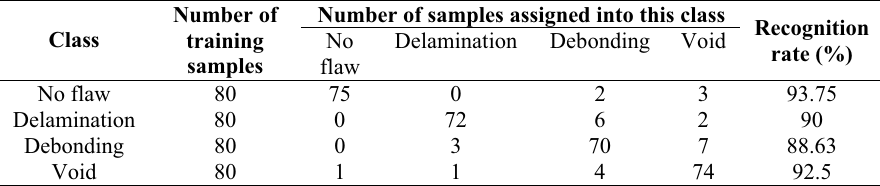
Table 6. Classification result using EMD_RSAR based features